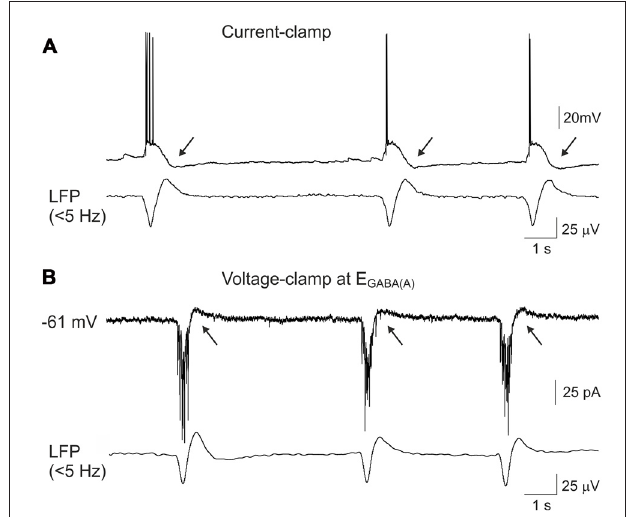
FIGURE 4 | Outwardly directed currents during GDPs-AHP. (A) Current-clamp and (B) voltage- clamp gramicidin perforated patch recordings of GDPs in a CA3 pyramidal cell and concomintant local field potential (LFP) recordings from CA3 pyramidal cell layer (lowpass filter 5 Hz). Voltage-clamp recordings shown on (B) were performed at the holding potential corresponding to the reversal potential of the GABA(A) receptor mediated currents ( − 61 mV) and the inwardly directed currents during GDPs are mediated by the glutamate receptors. GDP-AHP (A) and outwardly directed currents during GDP-AHP under voltage-clamp (B) are marked by arrows.